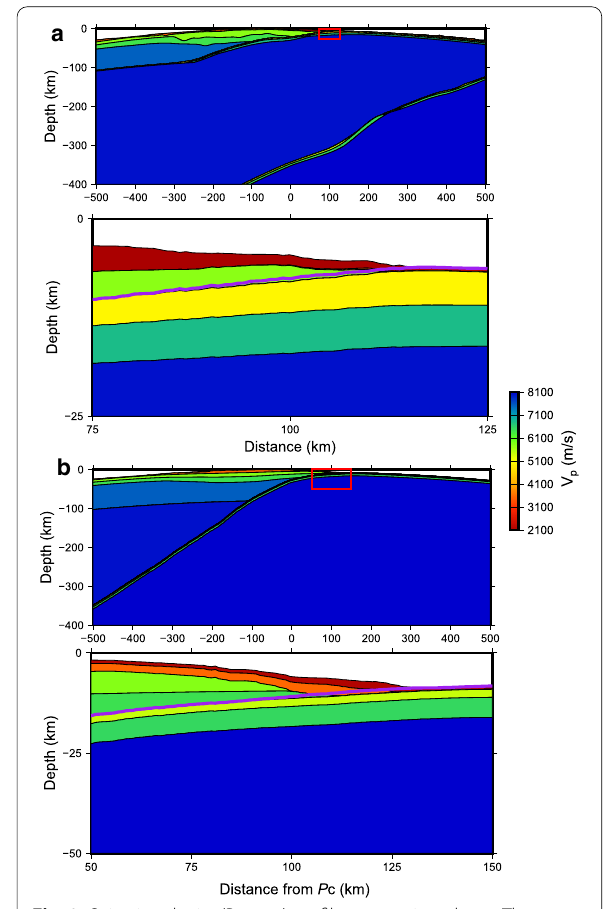
Fig. 2 Seismic velocity (P-wave) profiles on cutting planes. The profiles on the cutting plane along the red lines in Fig. 4 for the a Nankai Trough and b Japan Trench subduction zones are shown. The above panels are the overviews. The bottom panels are close-up views in the areas around the trough and trench axes denoted by the red rectangles in those above. The purple lines denote the newly generated curved surfaces by interpolating between the top surface of the subducting plate and the trough or trench